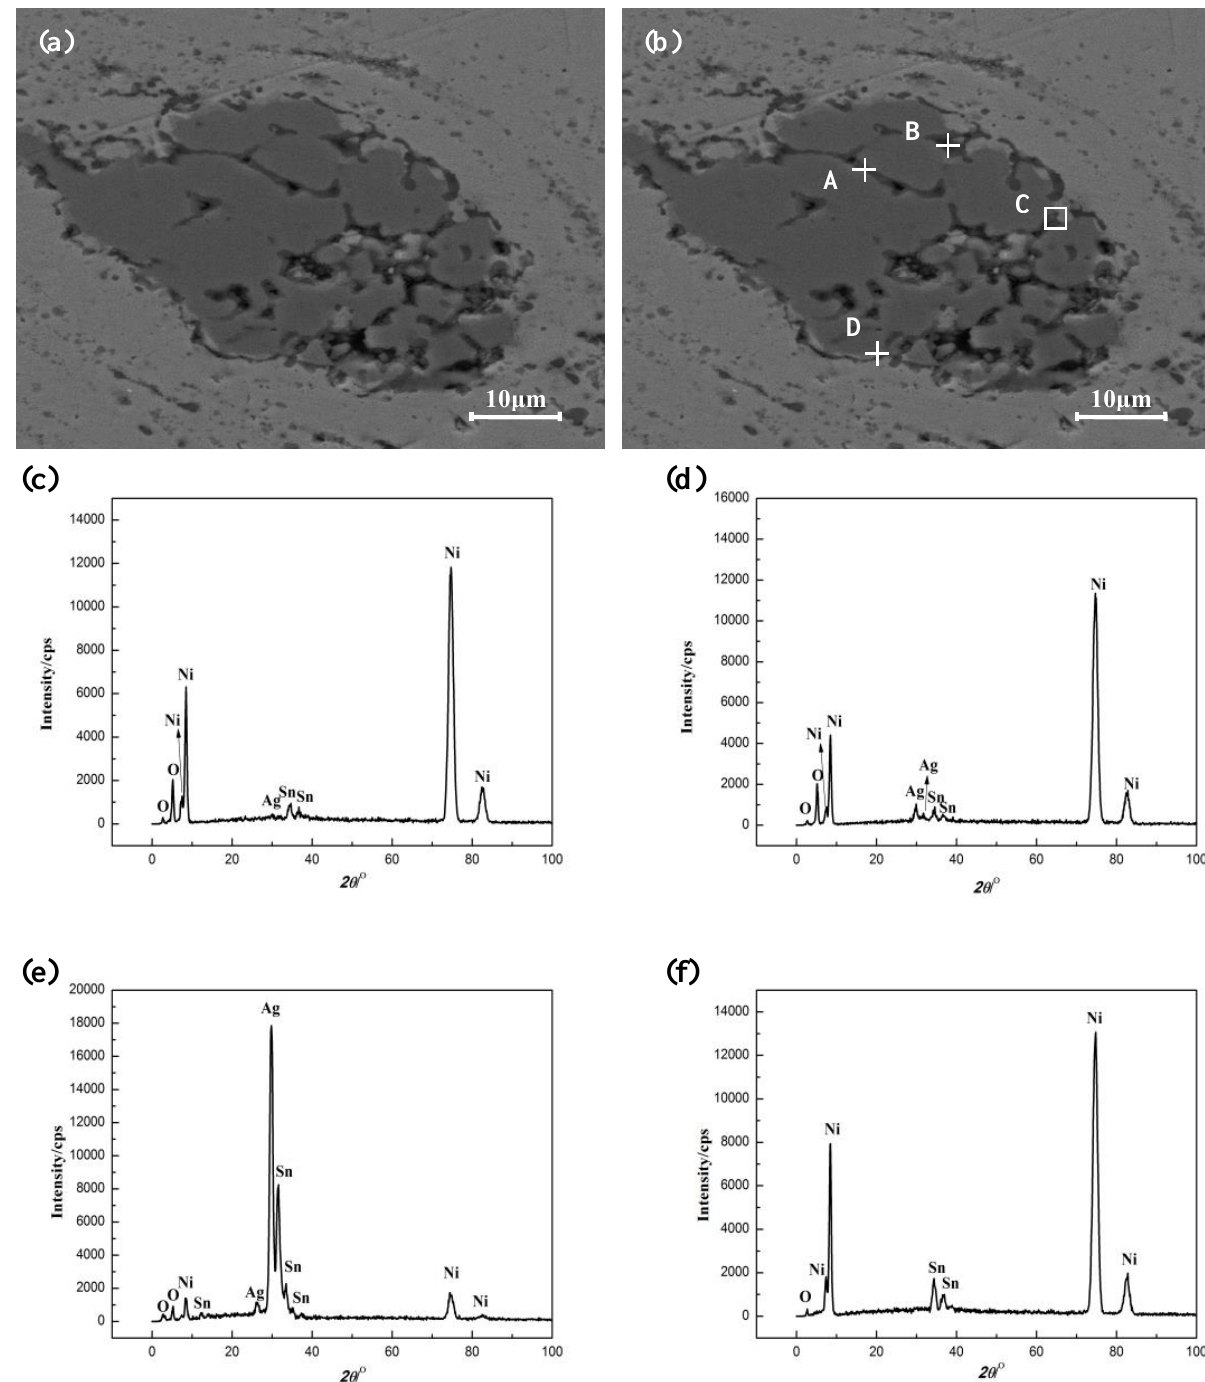
Figure 2: Surface morphology of the AgSnO 2 NiO composites and corresponding energy spectra: (c) region A; (d) region B; (e) region C; (f) region